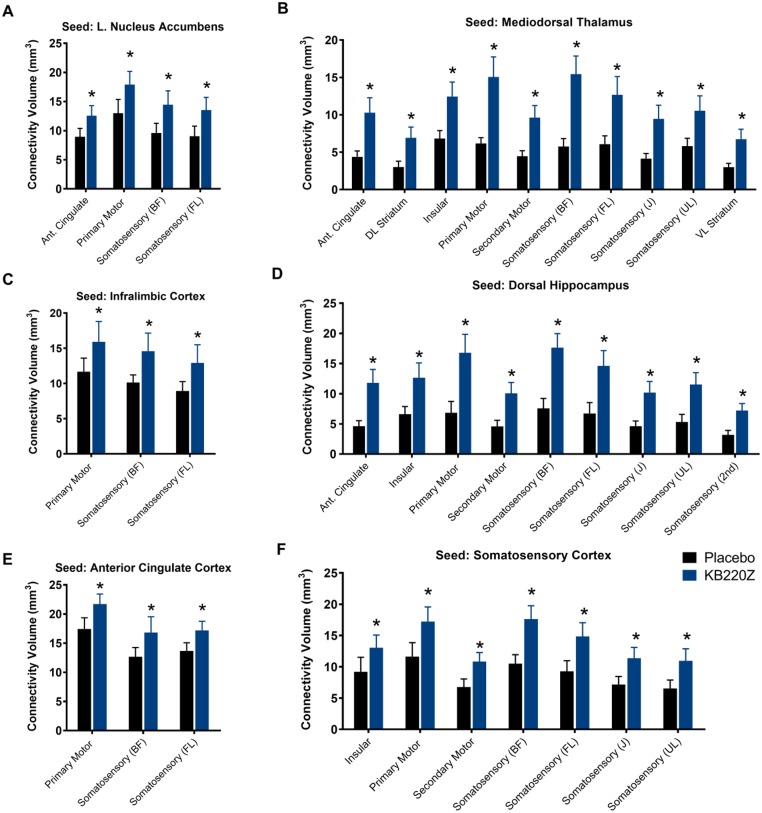
KB220Z increased the volume of connectivity.Connectivity volume was assessed by applying a correlation threshold value of z = 0.3 to all subjects and quantifying the volume above this threshold. Voxels were then converted to mm3 based on 3D voxel resolution. Shown are connectivity volume data for various regions including (A), nucleus accumbens, (B) mediodorsal thalamus, (C) infralimbic cortex, (D) dorsal hippocampus, (E) anterior cingulate cortex, and (F) somatosensory cortex. *Significantly different from placebo t ≥ 3.4 p ≤ 0.05 with multiple comparison corrections using the Holm-Sidak method. Sixty-five ROI were analyzed for each seed in A-F and areas of the brain with increases in functional connectivity with KB220Z treatment are shown.